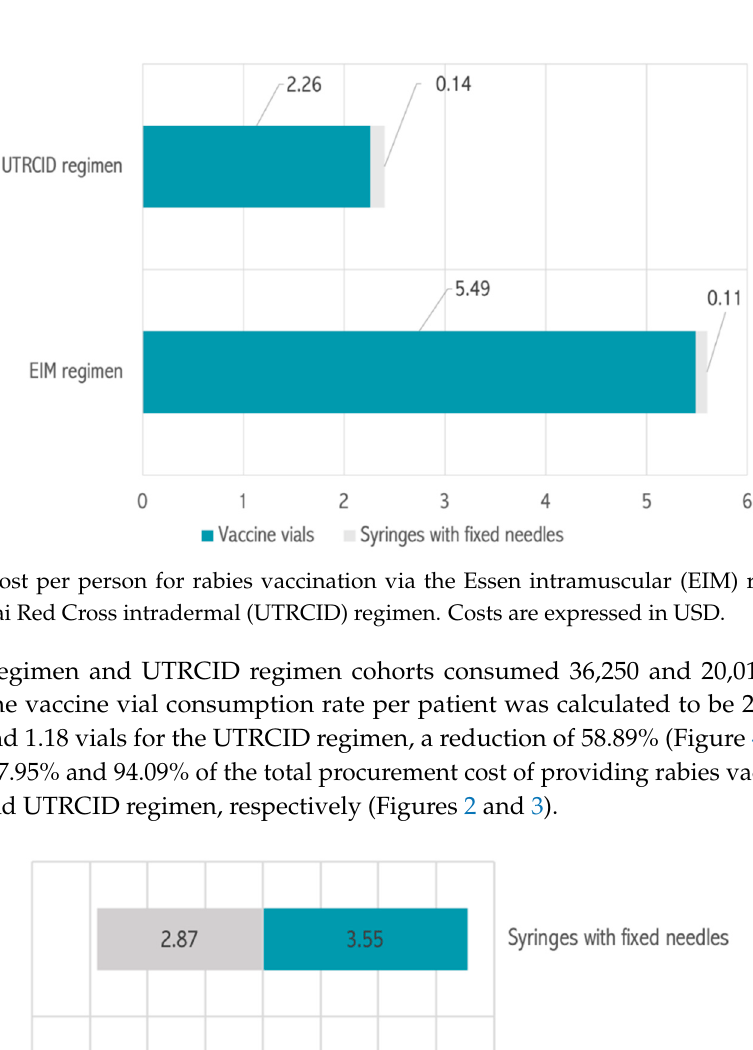
Figure 2. Costs borne by our hospital for providing rabies vaccination for a period of one year via the Essen intramuscular (EIM) regimen and updated Thai Red Cross intradermal (UTRCID) regimen. Costs are expressed in USD. n = number of patients.